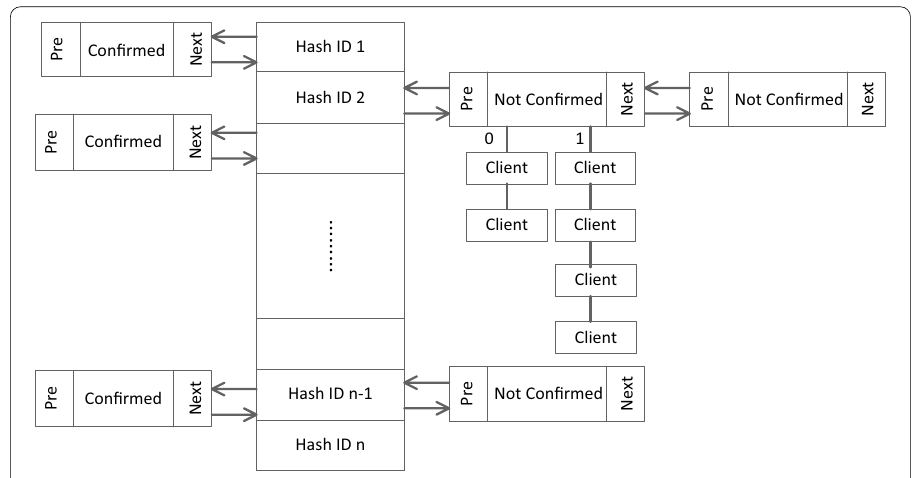
Fig. 2 Two level hash table of LVR. LVR adopts a second-level data structure. Hash the service IDS according to the size of the hash table as the first-level hash and then establish the second-level index according to the service IDS after the data items are read. The left side is the hash of the confirmed evaluation, and the right side is the hash of the unconfirmed evaluation. Unevaluated hash retains the ID of the evaluated node according to the evaluated